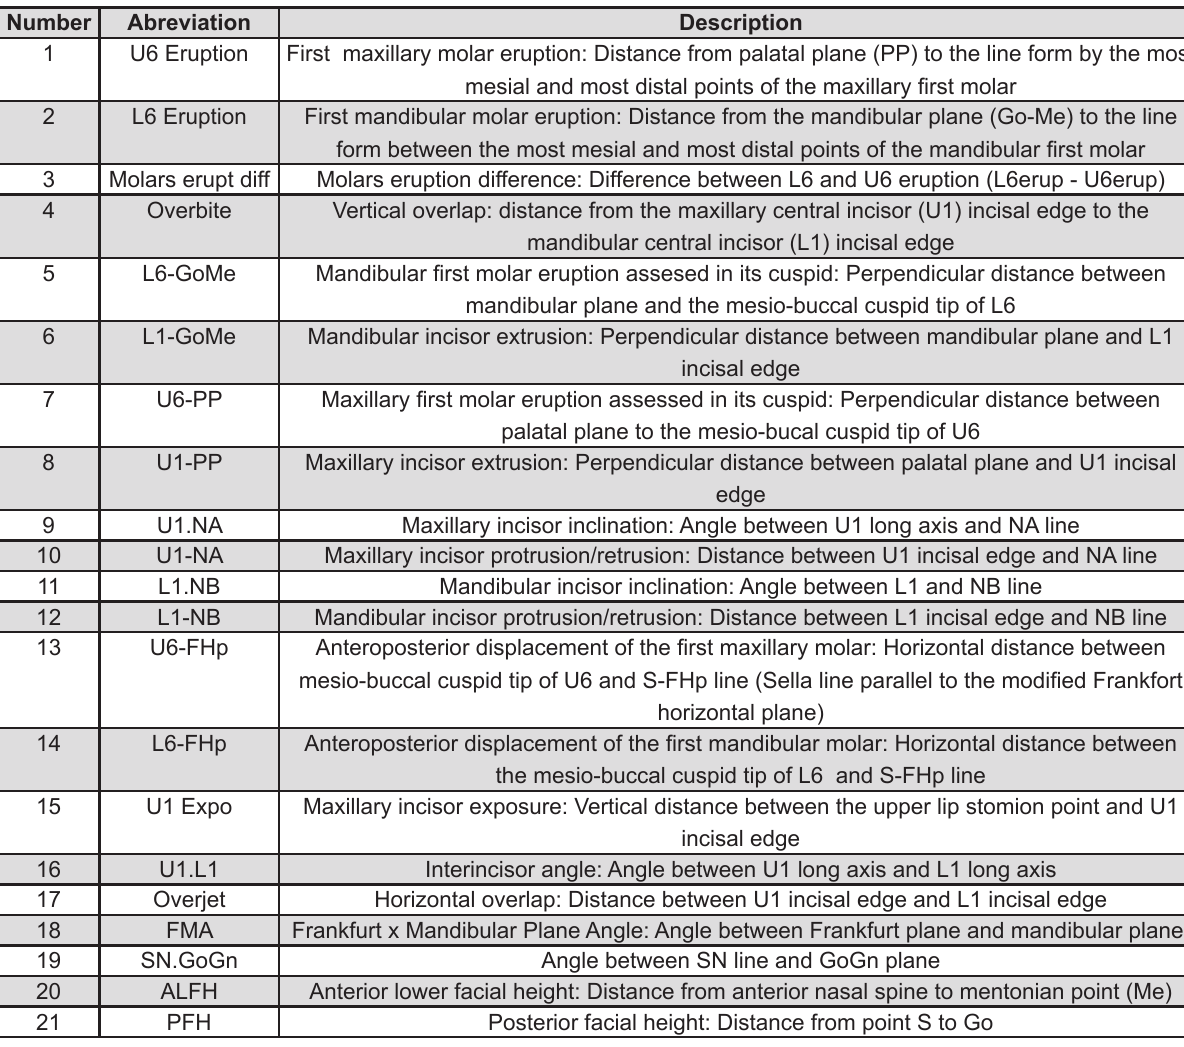
Figure 4- Dentoalveolar variables used and their